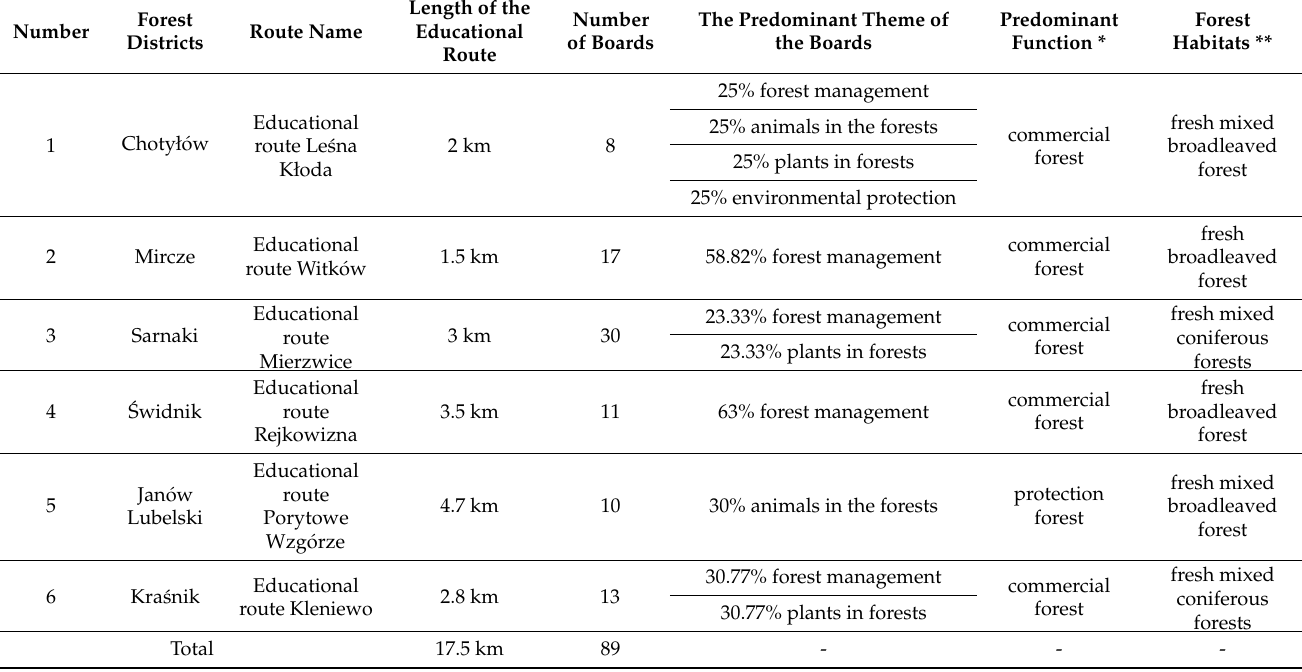
Table 1. Technical and environmental parameters of educational